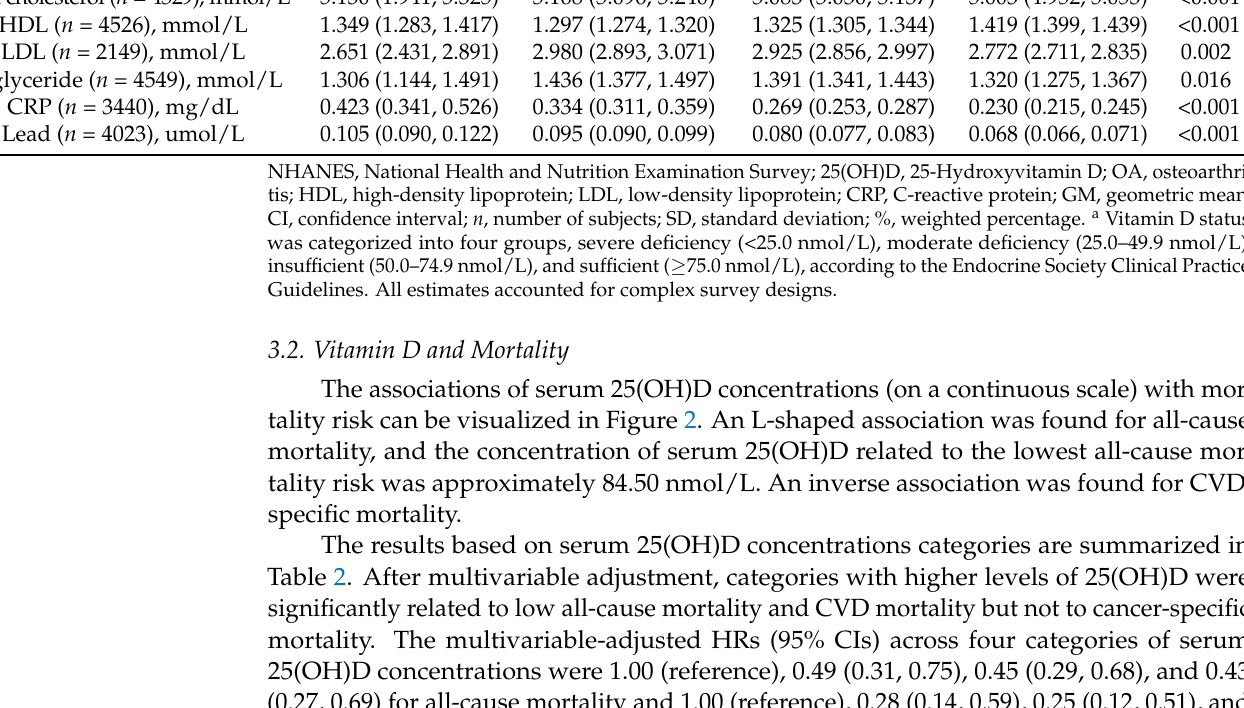
Table 2. After multivariable adjustment, categories with higher levels of 25(OH)D were